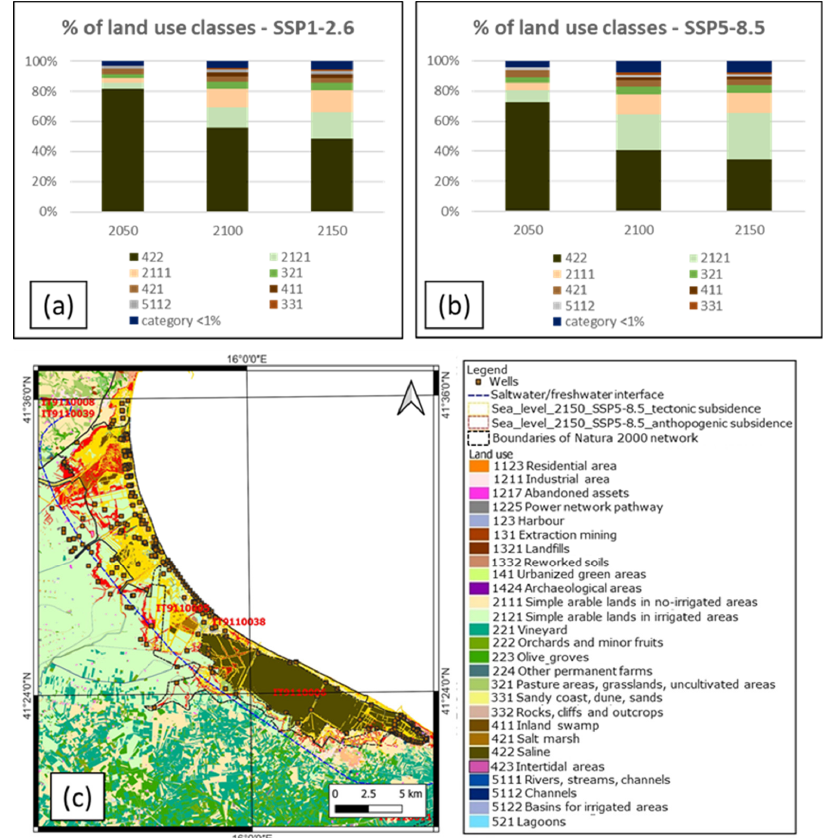
Figure 11. Percentage values of areas in each land-use category affected by sea-level rise in 2050, 2100, and 2150. ( a ) The percentages refer to the total area flooded in the SSP1-2.6 scenario. ( b ) The percentages refer to the total area flooded in the SSP5-8.5 scenario. All the land-use categories showing a percentage value of lower than 1% are grouped in a single class. ( c ) Influence of sea-level rise (SSP5-8.5, time step 2150) on the land use of Tavoliere delle Puglie with associated saltwater/freshwater edge (data from Apulia Region, 1984 [51]).